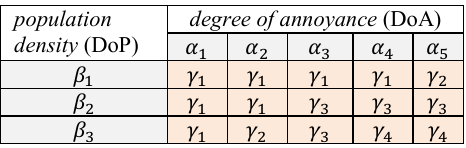
Table 3. Table used to represent the fuzzy relation R